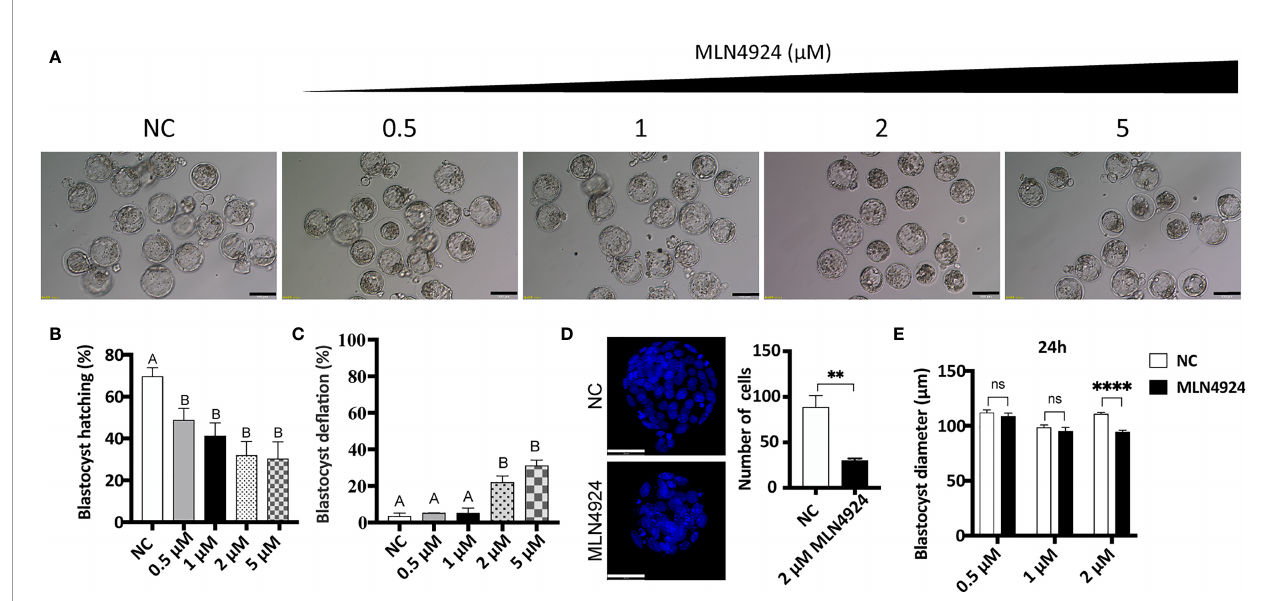
FIGURE 1 | Abnormal embryo growth, development, and impaired blastocyst hatching after MLN4924 treatment in mouse embryos. (A) Images of blastocysts in the control group and MLN4924-treated groups. Blastocysts were cultured in a medium with different concentrations of MLN4924 (0.5 m M, 1 m M, 2 m M, and 5 m M) or without MLN4924. The number of blastocysts in each group is 90. Scale bar for 200 m m. (B) Blastocyst hatching rate of control and MLN4924-treated embryos. Error bars represent the standard error. (C) Shrinkage blastocyst rate of control (n = 60) and MLN4924-treated embryos (n = 60). Error bars represent the standard error. (D) Images of blastocysts nucleus in the control group and MLN4924-treated group (2 m M). The histogram is the cell count of the control group and the MLN4924-treated blastocysts. Scale bar for 50 m m. (E) Diameters of blastocysts in NC and MLN4924-treated groups after 24